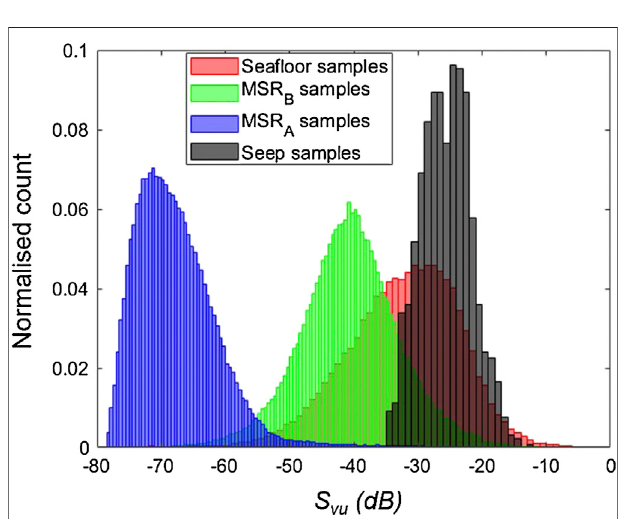
FIGURE 11 | Histograms of WCD samples S vu values by region. Blue samples are from data in the MRS A region, green samples are from the MSR B region, red samples are samples impacted by the echo of the sea fl oor and black samples are from within a gas seep feature. All except for the seep samples were from data within a single ping. Seep samples were collated over a series of pings due to the low number of seep target samples within a single ping.